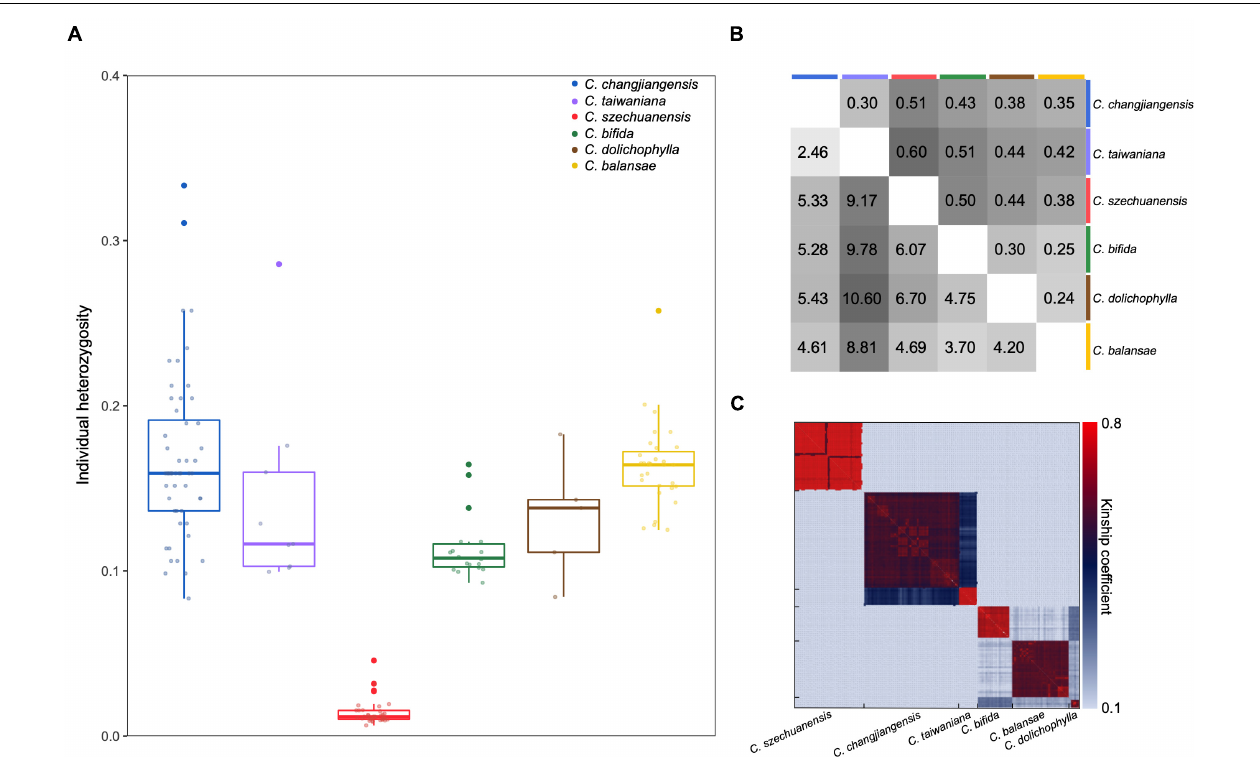
FIGURE 2 | Genetic diversity and differentiation among the six Cycas species. (A) Individual heterozygosity for each species; (B) Pairwise genetic differentiation ( F ST , upper triangular matrix) and pairwise sequence divergence ( D XY , × 10 − 3 , lower triangular matrix); and (C) Pairwise kinship coefficients among individuals within each species and between